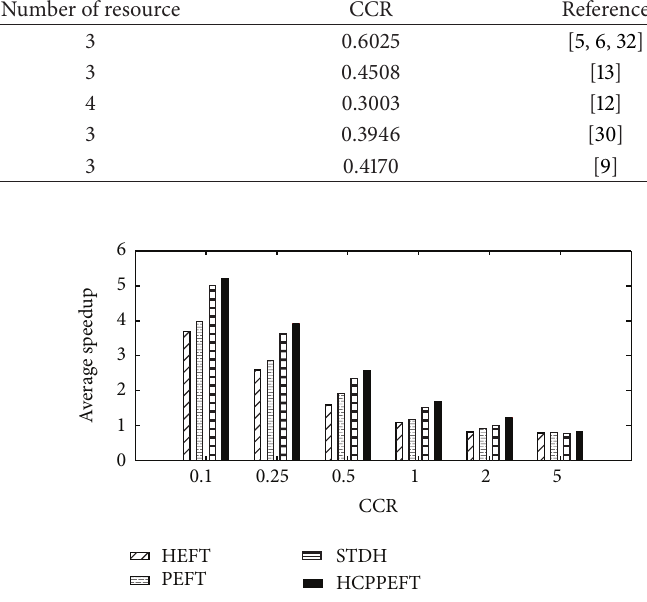
Figure 5: Average speedup with CCR = 2 for random task graphs.